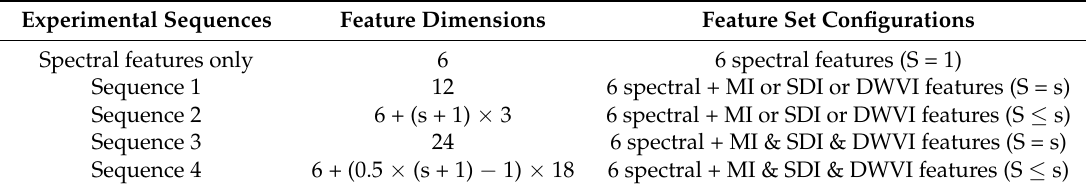
Table 1. Different feature set configurations used in this